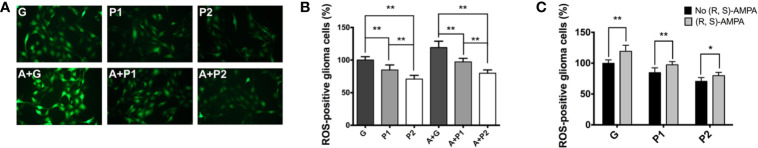
Oxidative stress status was investigated using ROS assay. (A) Fluorescence image of cellular ROS productive levels (magnification, ×200). (B, C) Quantification of ROS levels in the gliomas. Data are presented as the mean ± SD (n=6/group). *P < 0.05 and **P < 0.01. Groups: S, sham; G, glioma; P1 and P2, propofol 1.2, and 4.4 µg/ml-1, respectively; A, (R, S)- AMPA. ROS, reactive oxygen species; AMPA, α-amino-3-hydroxyl-5-methyl-4-isoxazolepropionic acid.